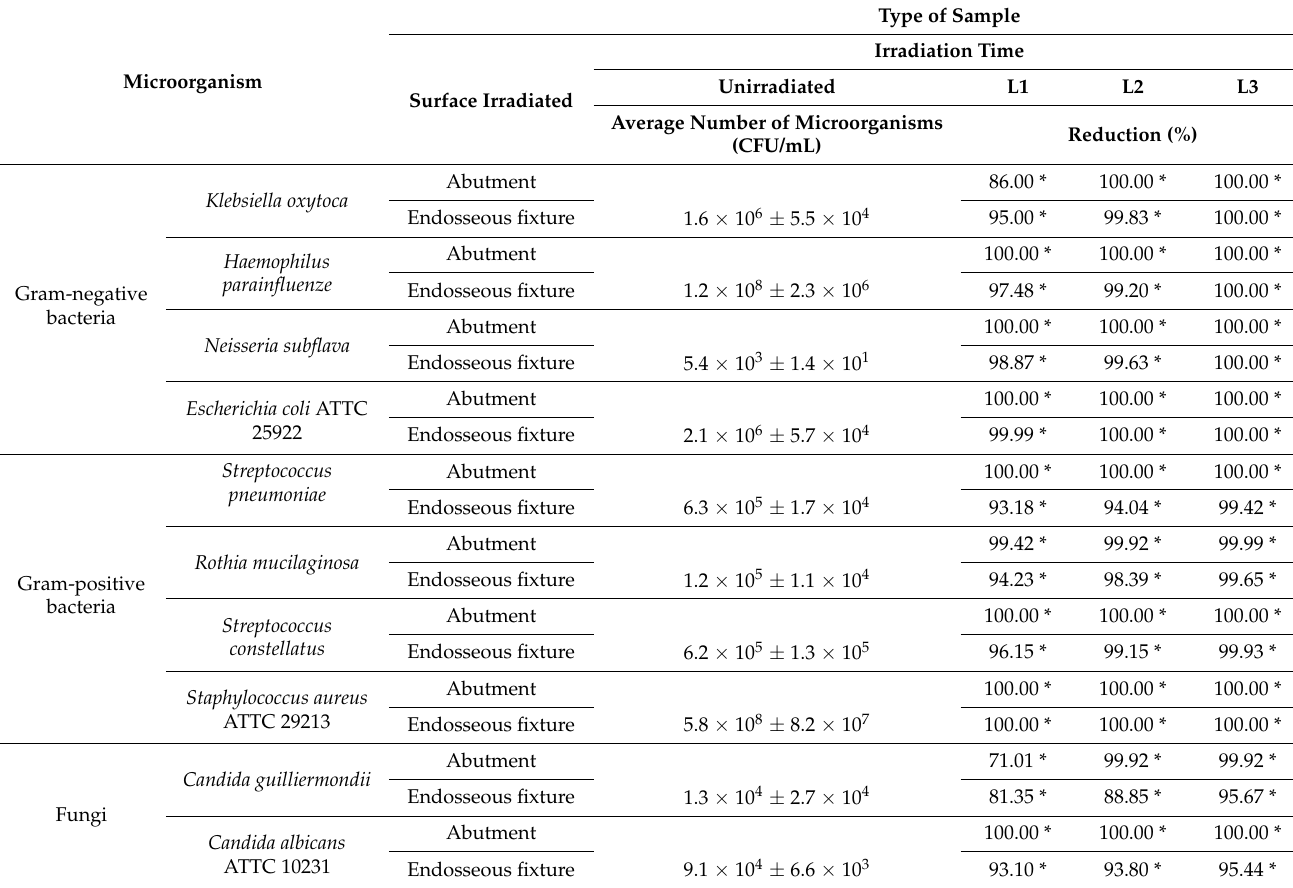
Table 2. Percent reduction in the number of microorganisms isolated from the patients with periimplantitis after laser irradiation in 3 variants: L1: 1 × 15 s, L2: 2 × 15 s, L3: 3 × 15